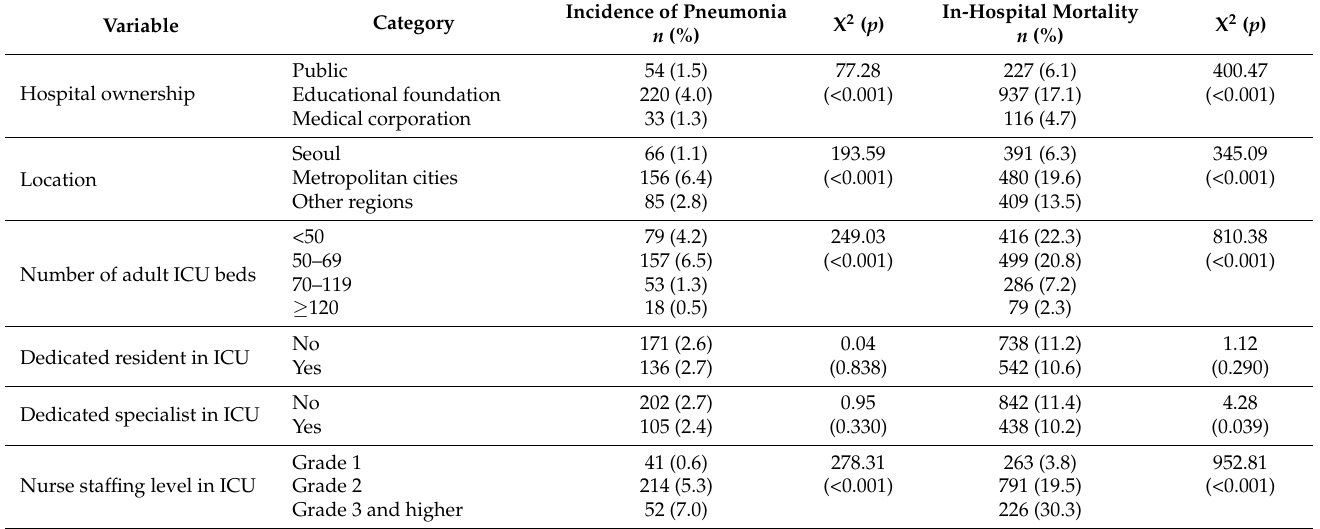
Table 4. Hospital-acquired pneumonia and in-hospital mortality according to hospital characteristics ( n =